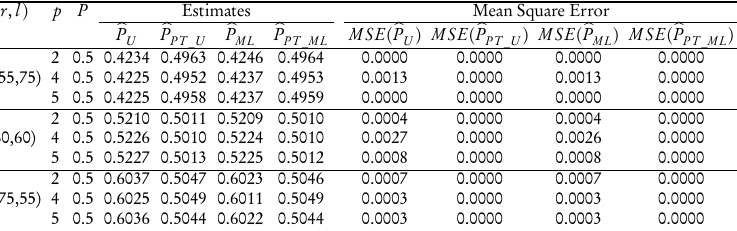
Estimates and corresponding mean square error of P. The values are truncated to 4 decimal points, therefore few values in the column of mean square error being very small are mentioned as